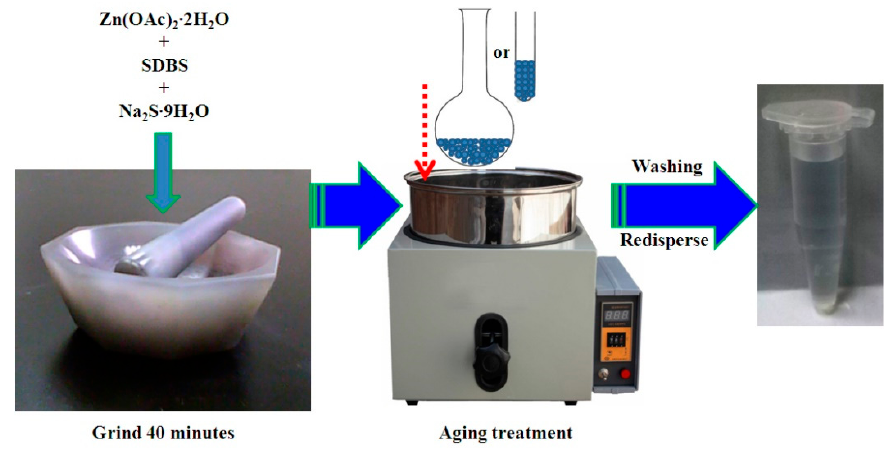
Figure 1. An improved mechanochemical recipe for quantized structures.